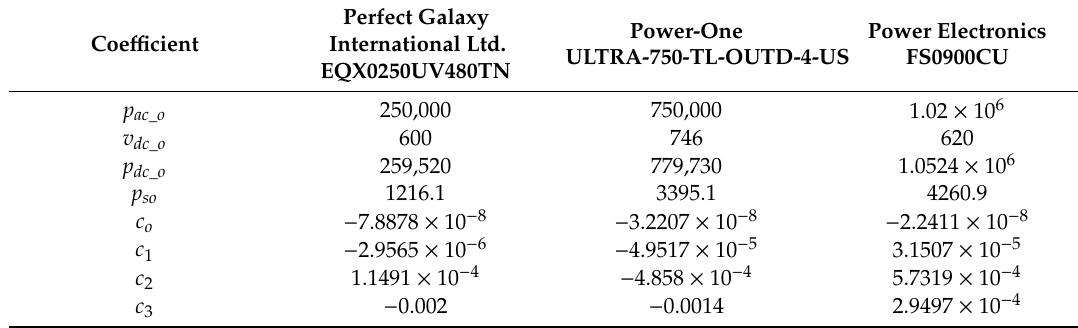
Table 9. Sandia coe ffi cients.